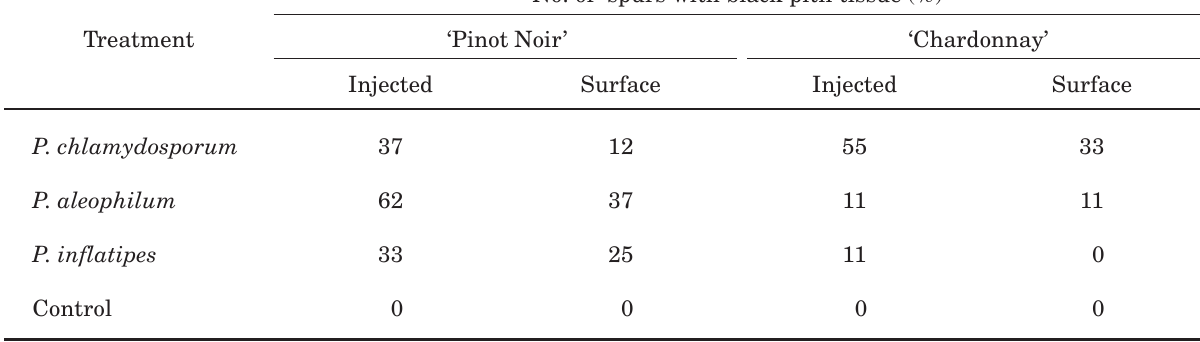
Table 5. Black discoloration in pith tissue of spurs of standing vines of cv. Pinot Noir and Chardonnay inoculated with Phaeoacremonium chlamydosporum, P. aleophilum and P. inflatipes . Pathogens were either injected into the pith or applied as a drop of spore suspension to the cut surface of grapevine spurs.